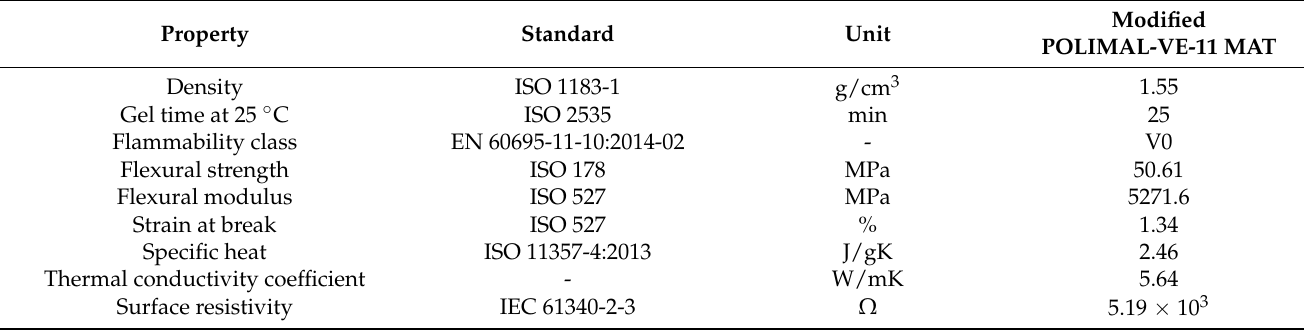
Table 2. Properties of matrix